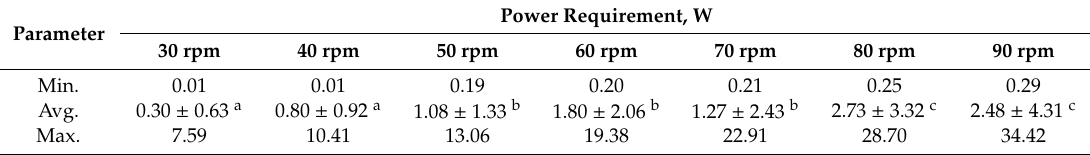
Figure 11. Power consumption of the picking device in different speed conditions. Table 8. Results of power consumption according to speed